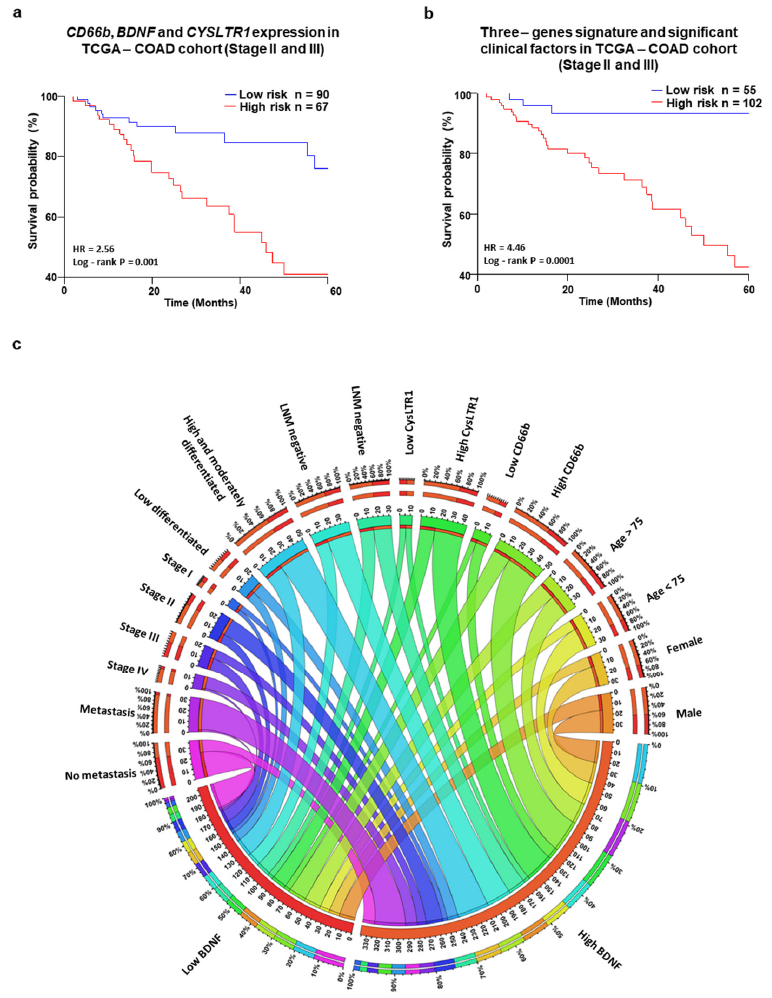
Figure 6. CD66b neutrophil, BDNF and CysLT 1 R expression with significant clinicopathological factors impact patient survival probability. Kaplan–Meier survival curves according to ( a ) three-gene signature ( CD66b , BDNF and CYSLTR1 ) expression and ( b ) multivariate analysis of the three-gene signature with the significant clinical features in stage II and III in TCGA-COAD patient cohort. ( c ) Circos plot showing the association between low and high BDNF expression and tumor stage, lymph node metastasis, tumor size, sex and age group involved in colon cancer, and the number of metastatic patients at diagnosis. The frequency of occurrence of different factors, such as BDNF protein expression pattern and tumor stage, is depicted in the outer ring. The inner ring of the Circos plot depicts the association between the BDNF protein expression pattern and tumour stages. The thickness of each color shows the frequency of correlation with factors specifically related to BDNF protein